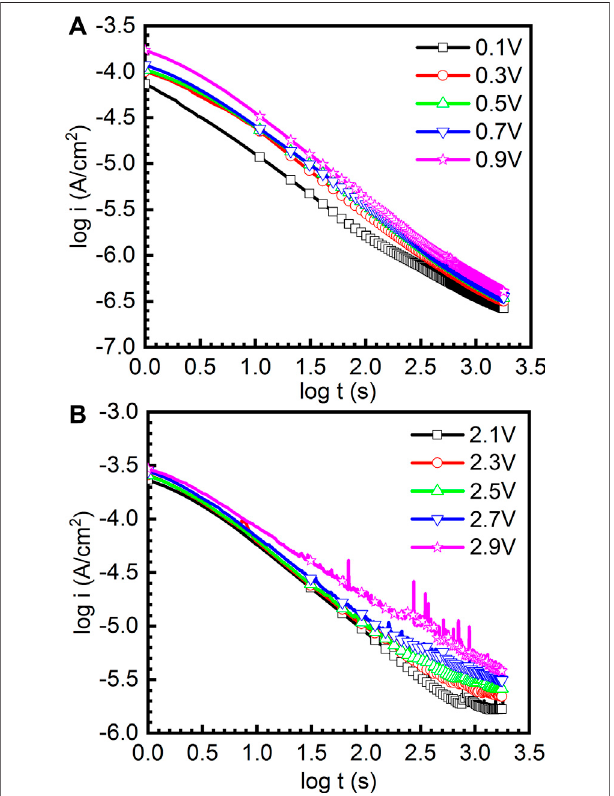
FIGURE 4 | Double-log plots of current-time of as-cast Ti-6Al-4V in the potentiostatic polarization tests under different fi le formation potentials in